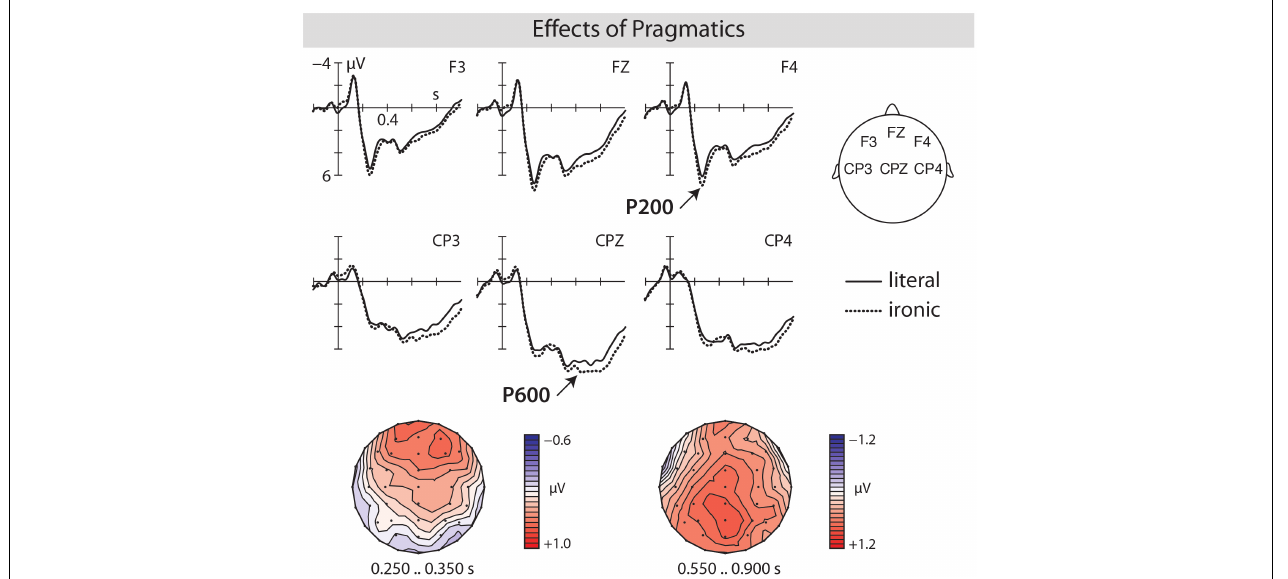
FIGURE 1 | Grand average ERPs elicited by sentence final words achieving a literal meaning (solid line) and an ironic meaning (dotted line) with respect to the preceding context. For irony relative to literal language a P200–P600 pattern was elicited, in absence of an enhanced N400. The scalp distribution of the effects is shown by the topographic maps below. Note that the scaling of the topographic maps in all figures was adapted to the amplitude size of the effects.